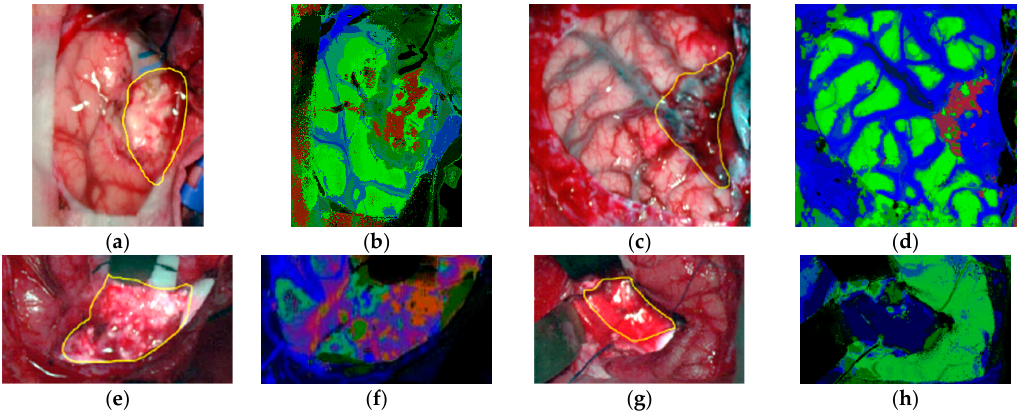
Figure 12. Tumor tissue identification results obtained from the validation database employing the HELICoiD demonstrator in [171]. ( a , c , e , g ) Synthetic RGB images; ( b , d , f , h ) Thematic maps of the HS image, where the tumor tissue is represented in red color, the normal tissue in green, the hypervascularized tissue in blue and the background in black. Reproduced from [171]; Creative Commons BY 4.0; published by MDPI (2018).